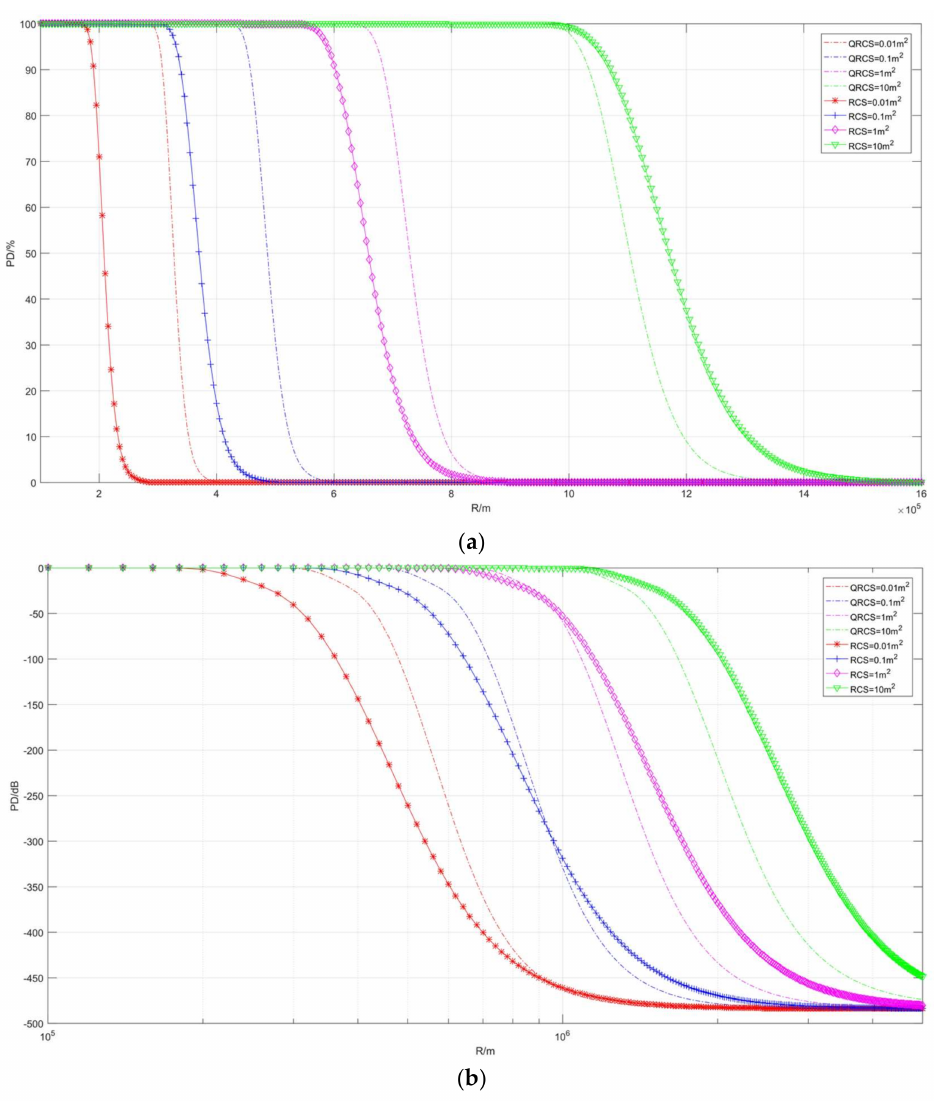
Figure 9. Correlation diagram of detection probability changing with distance (taking different RCS and QRCS). ( a ) P D /%, ( b ) P D